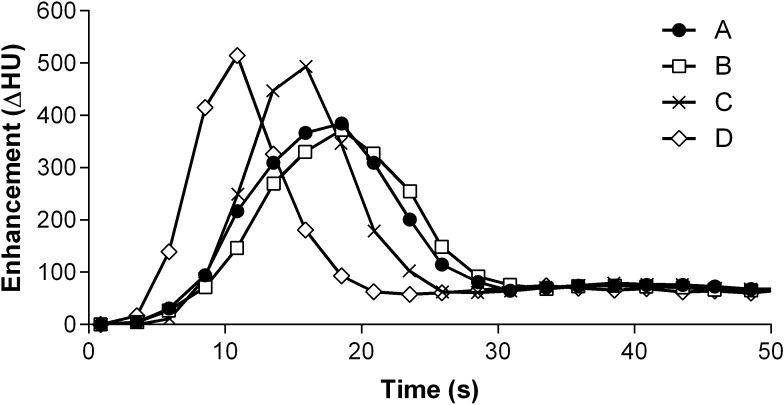
Group averaged TAC’s adjusted to identical peak time for protocols A, B, C and D measured in the descending aorta.